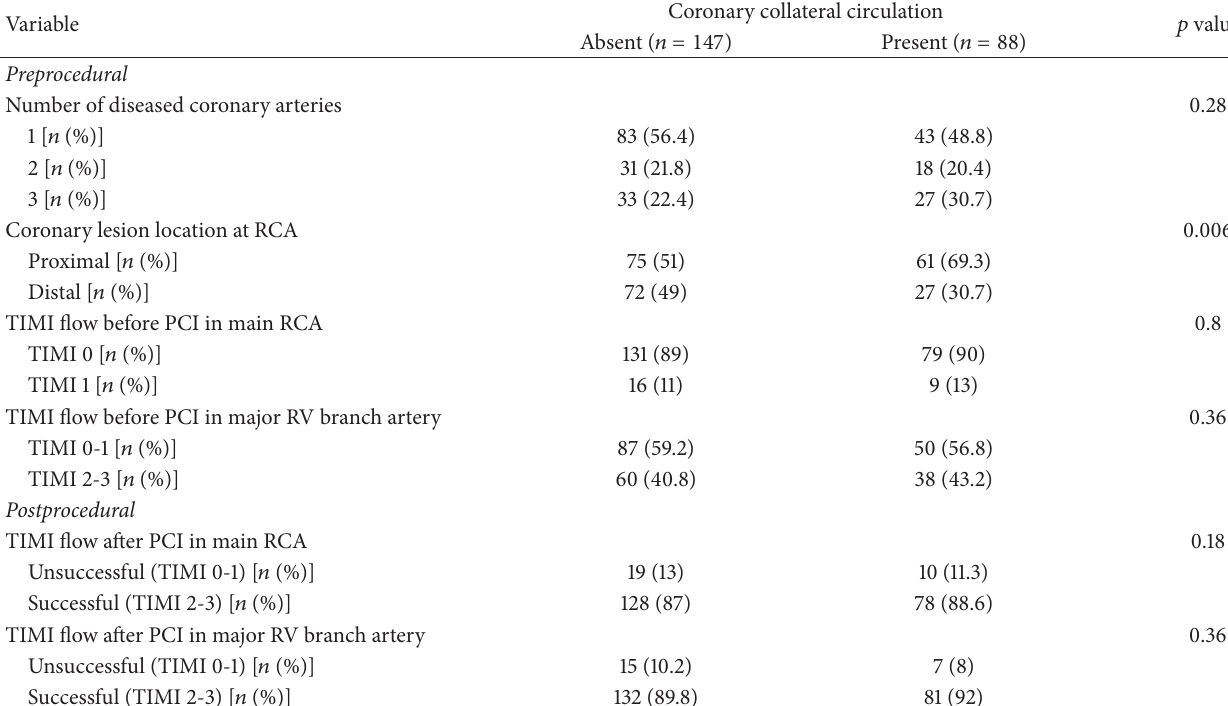
Table 2: Preprocedural and postprocedural angiographic characteristics related to coronary collateral circulation. Variable